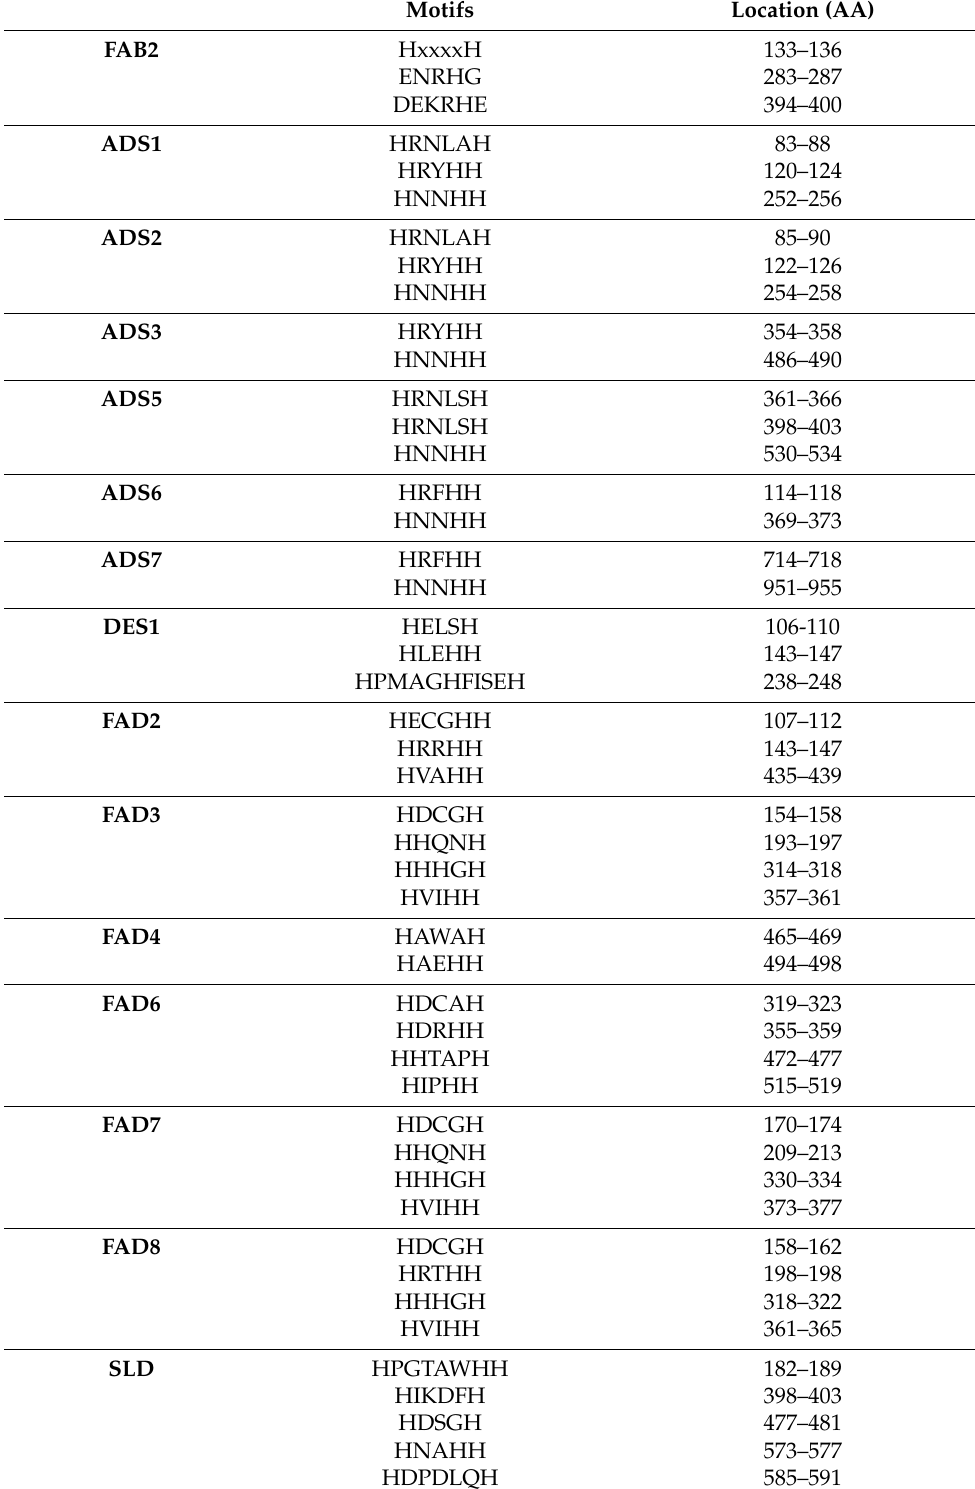
Table 2. Histidine motifs of fatty acid desaturases in A. thaliana and C. sativa